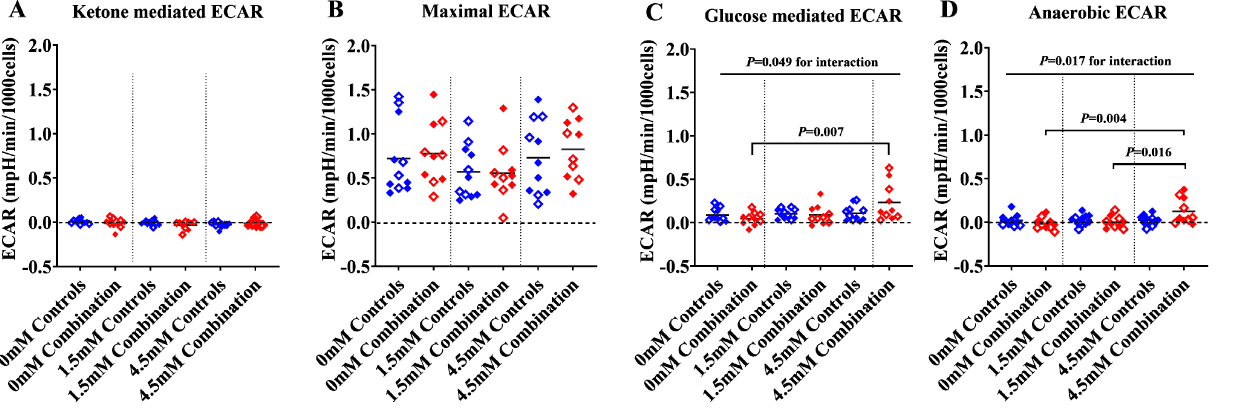
Figure 3. Ketones improve glucose mediated and anaerobic ECAR in combination exposed, but not in control, NRCM. ( A ) Ketone mediated ECAR, ( B ) Maximal ECAR, ( C ) Glucose mediated ECAR, and ( D ) Anaerobic ECAR in control and combination exposed NRCM. Bars represent mean ECAR (n = 10–11 litter per group). Blue color indicates controls and red color indicates combination exposed. Open symbols in the graph indicate males and filled symbols indicate females. Interaction effect was determined by two-way ANOVA, and the group differences remain significant only in combination exposed NRCM by one-way ANOVA with p values, as shown in the figures. mM refers to the progressive concentration of β HOB